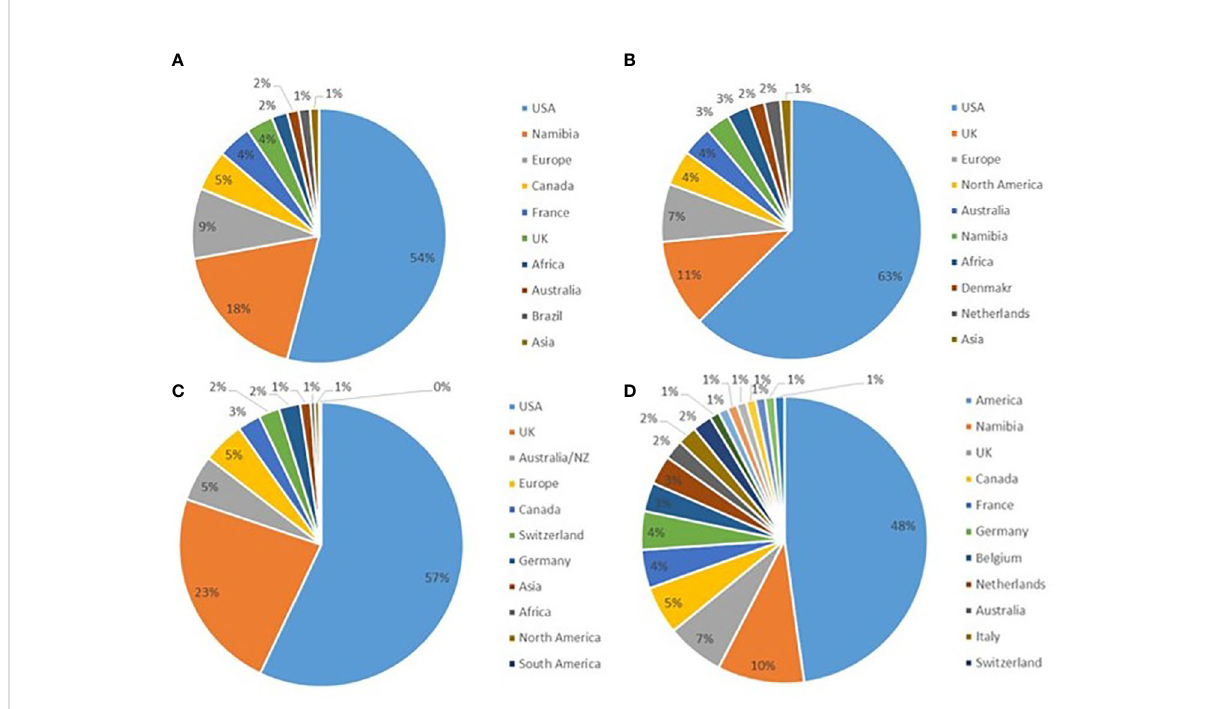
FIGURE 2 Country distribution of female (A) interns, (B) working guest, (C) Earthwatch volunteers and (D) survey participants. Countries that had less than 10 volunteers were analyzed as part of the